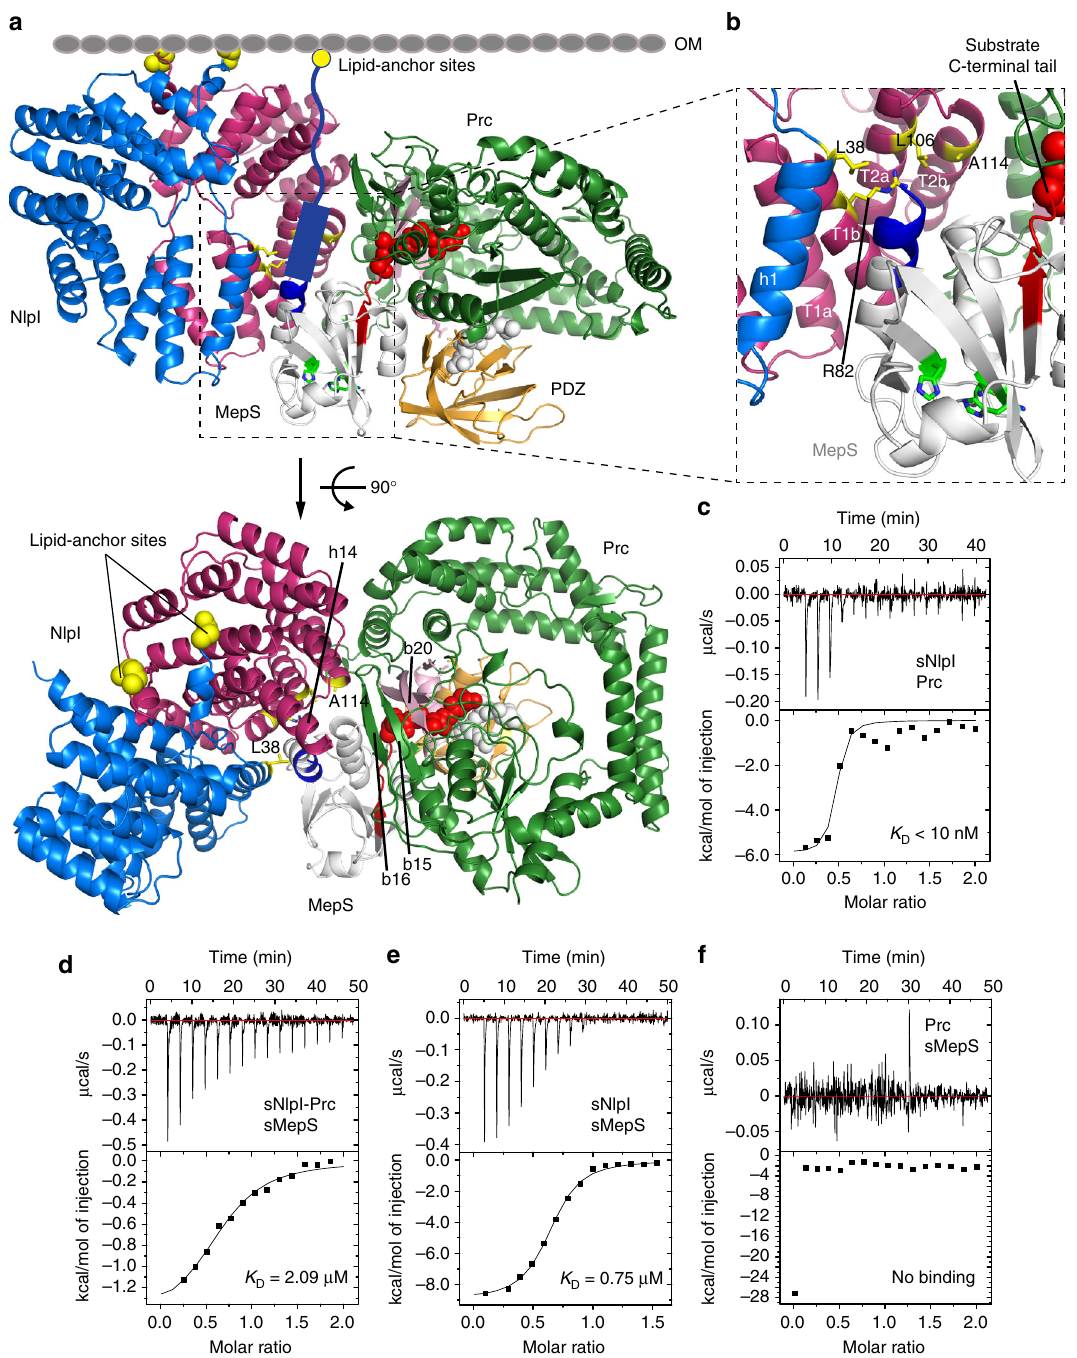
Fig. 6 Analysis of MepS docking to the NlpI-Prc complex. a Two orthogonal views of MepS (PDB code 2K1G) docked to the structure of the sNlpI-Prc complex. Left: view parallel to the outer membrane (OM; depicted by cartoon). The N-terminal residues linking to the lipobox Cys are shown in yellow spheres. The predicted N-terminal coil and helix of MepS, missing in the NMR structure, are depicted by cartoons. The C-terminal coil of docked MepS is colored in red to highlight its close proximity to the substrate entrance pore of Prc, where a bound peptide is shown in red spheres. The catalytic Ser – His – His triad of MepS is highlighted in green. Right: view of the model from the OM toward the periplasmic space. Only one complexed Prc (chain C) is shown. b Zoomed-in view showing the putative MepS binding site of NlpI. c ITC analysis characterizing the interaction of Prc with sNlpI. d – f ITC analysis of sMepS with the sNlpI-Prc complex d , sNlpI alone e , and Prc alone f . Raw data (top) and binding isotherm derived from the integrated heat (bottom) are shown. The K D values are